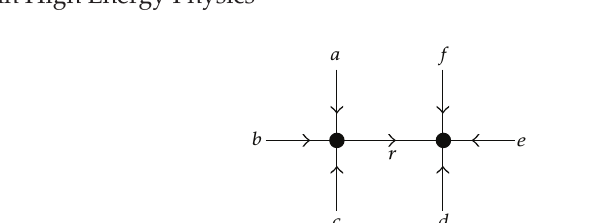
and I 0 is the tree-diagram